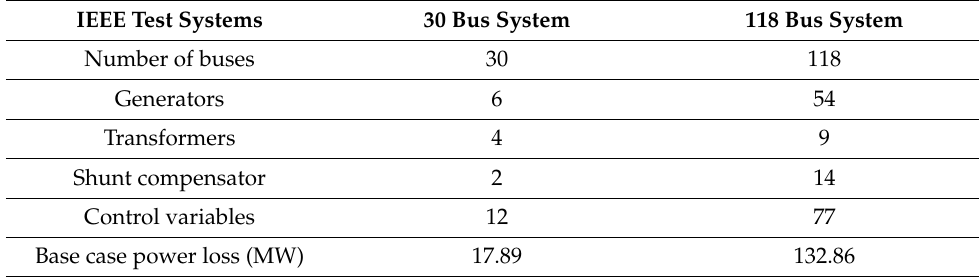
Table 3. Parameter of the test